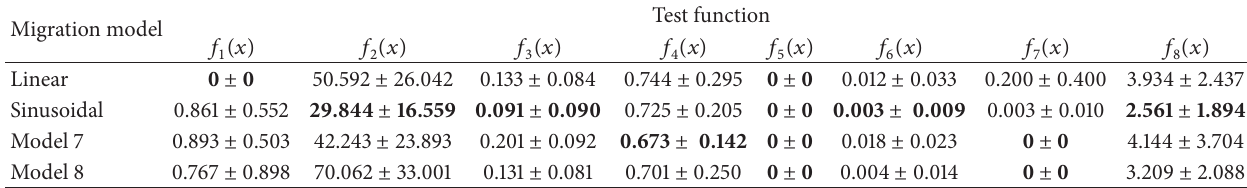
Table 1: Comparative results for the test functions. The smaller values are in bold.